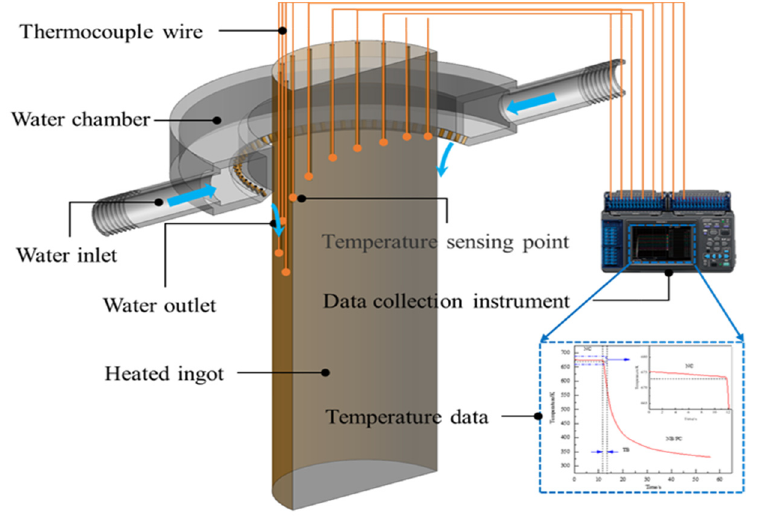
Figure 1. Schematic of DC spray rig and position of thermocouples.